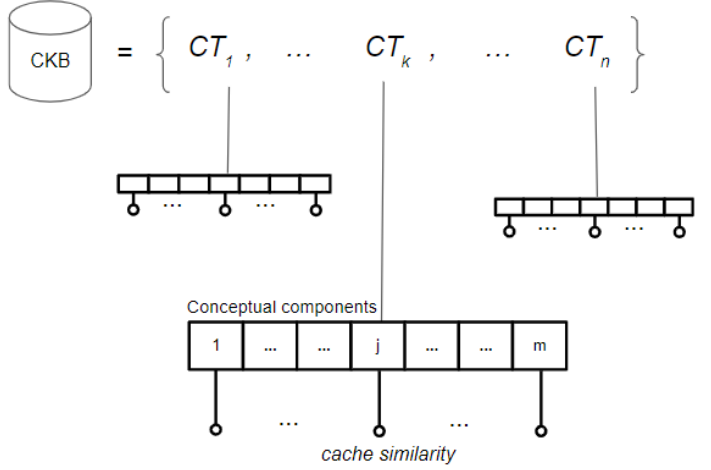
Figure 2. Cache structure for similarity between components. The clinical knowledge base is composed of case types, each one containing similarity cached values of its conceptual components.